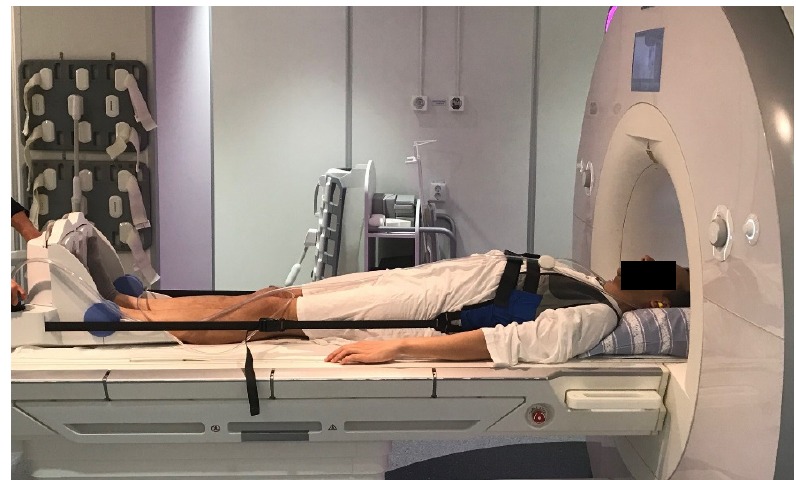
Figure 1. A patient positioned in the Dynawell ® compression device just about to undergo magnetic resonance imaging (MRI) examination.